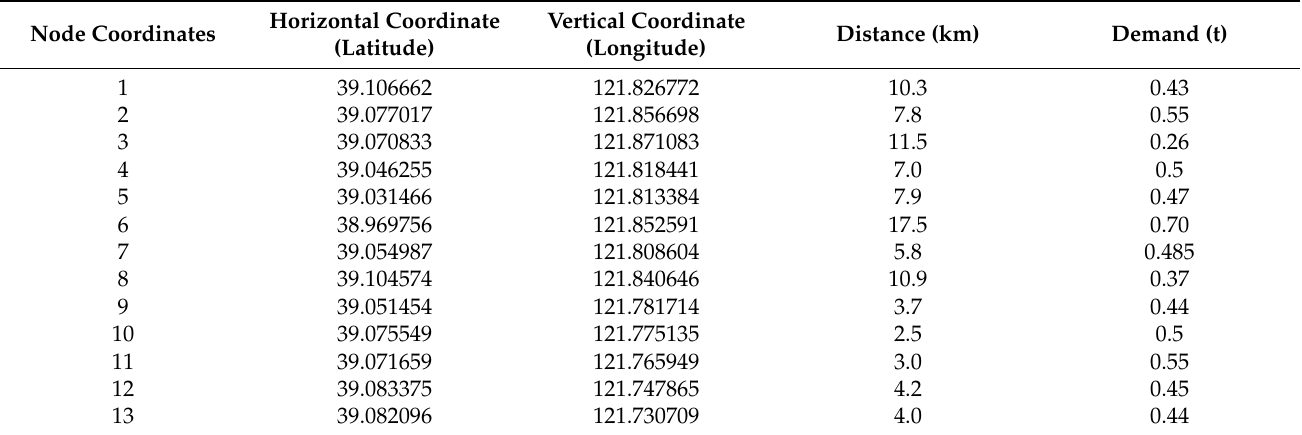
Table 4. Send point data information.